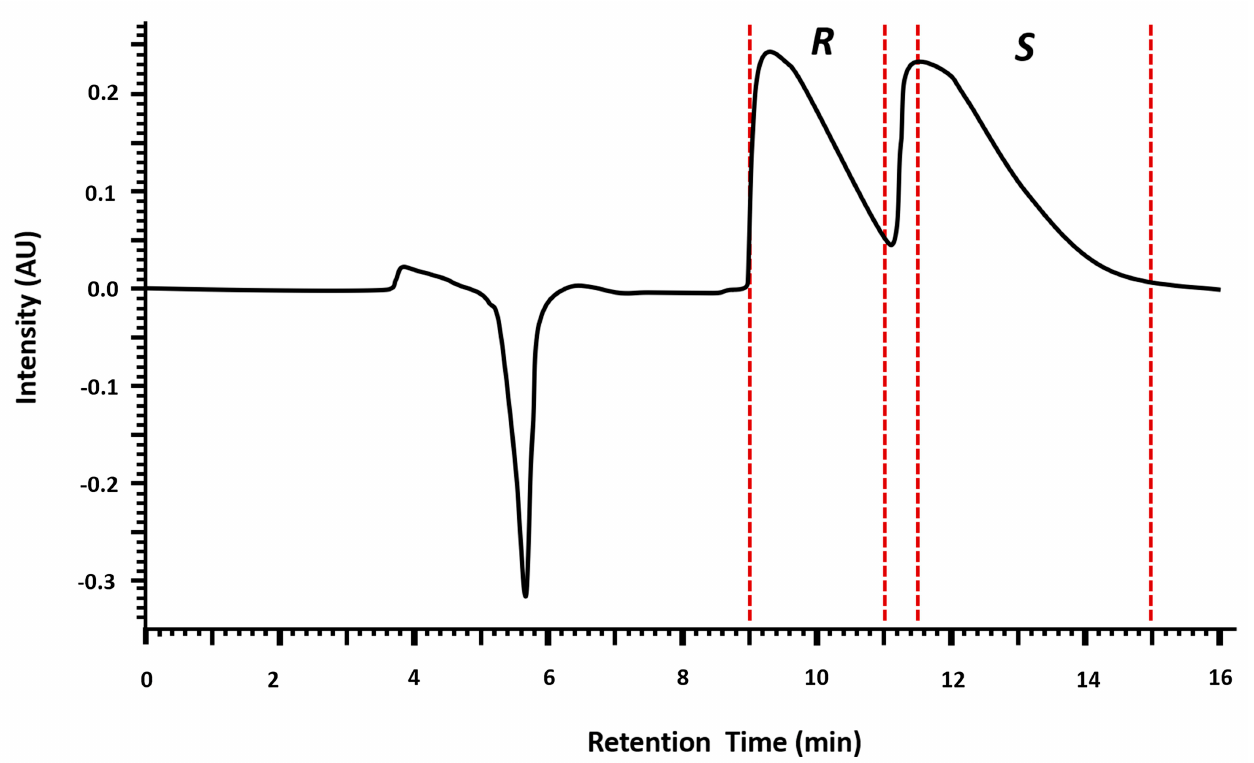
Figure 2. Chromatogram showing the enantioseparation of MDMA using a semipreparative amylose 3,5-dimethilphenylcarbamate column by LC-DAD. Mobile phase: n -Hex (0.1% DEA) and EtOH (0.1% DEA), 80:20 v / v ; flow rate: 1.5 mL min − 1 ; detector: 210 nm; injection volume: 20 µ L of solution at 30 mg mL − 1 (EtOH). The red dotted line corresponds to the cut-off time, that is, the time when each enantiomeric fraction was collected. ( R )-MDMA was collected from 9 min to 11 min, the intermediate fraction was collected from 11 min to 11.5 min and ( S )-MDMA was collected from 11.5 to 15 min.